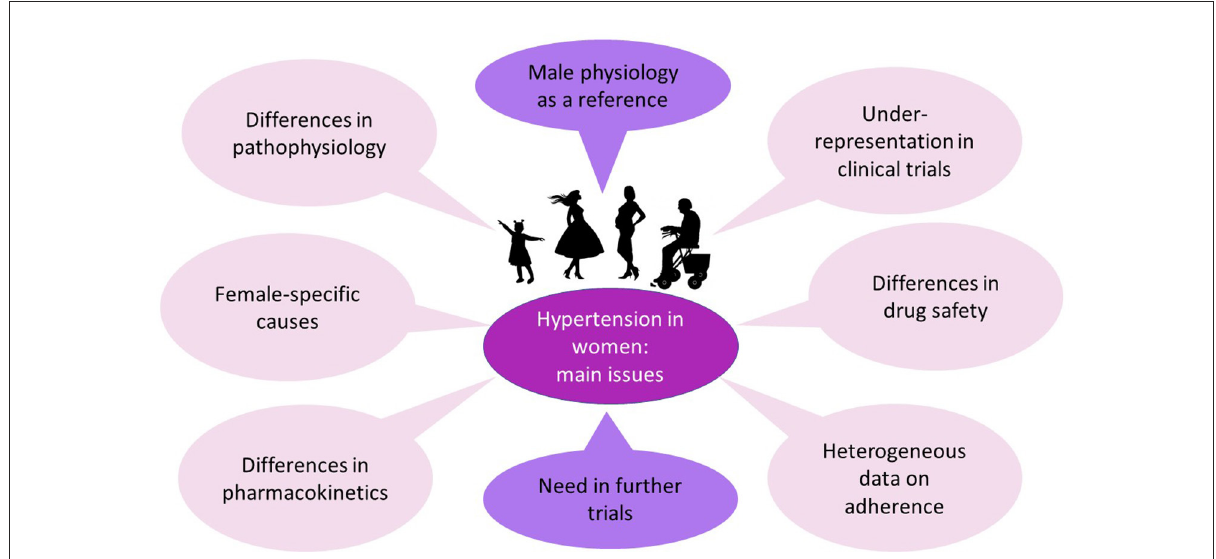
FIGURE3 Central Illustration Hypertension in women. Preclinical and clinical trials mainly include male animals and men. Nevertheless, the pathophysiology of hypertension has some sex-specific differences and female-specific causes (these differences and causes are described above). Sex differences in pharmacokinetics and drug safety have also been noted, whereas data on the efficacy of antihypertensive medications are contradictory. Therefore, further trials are needed, and their results may provide background for sex-specific guidelines for